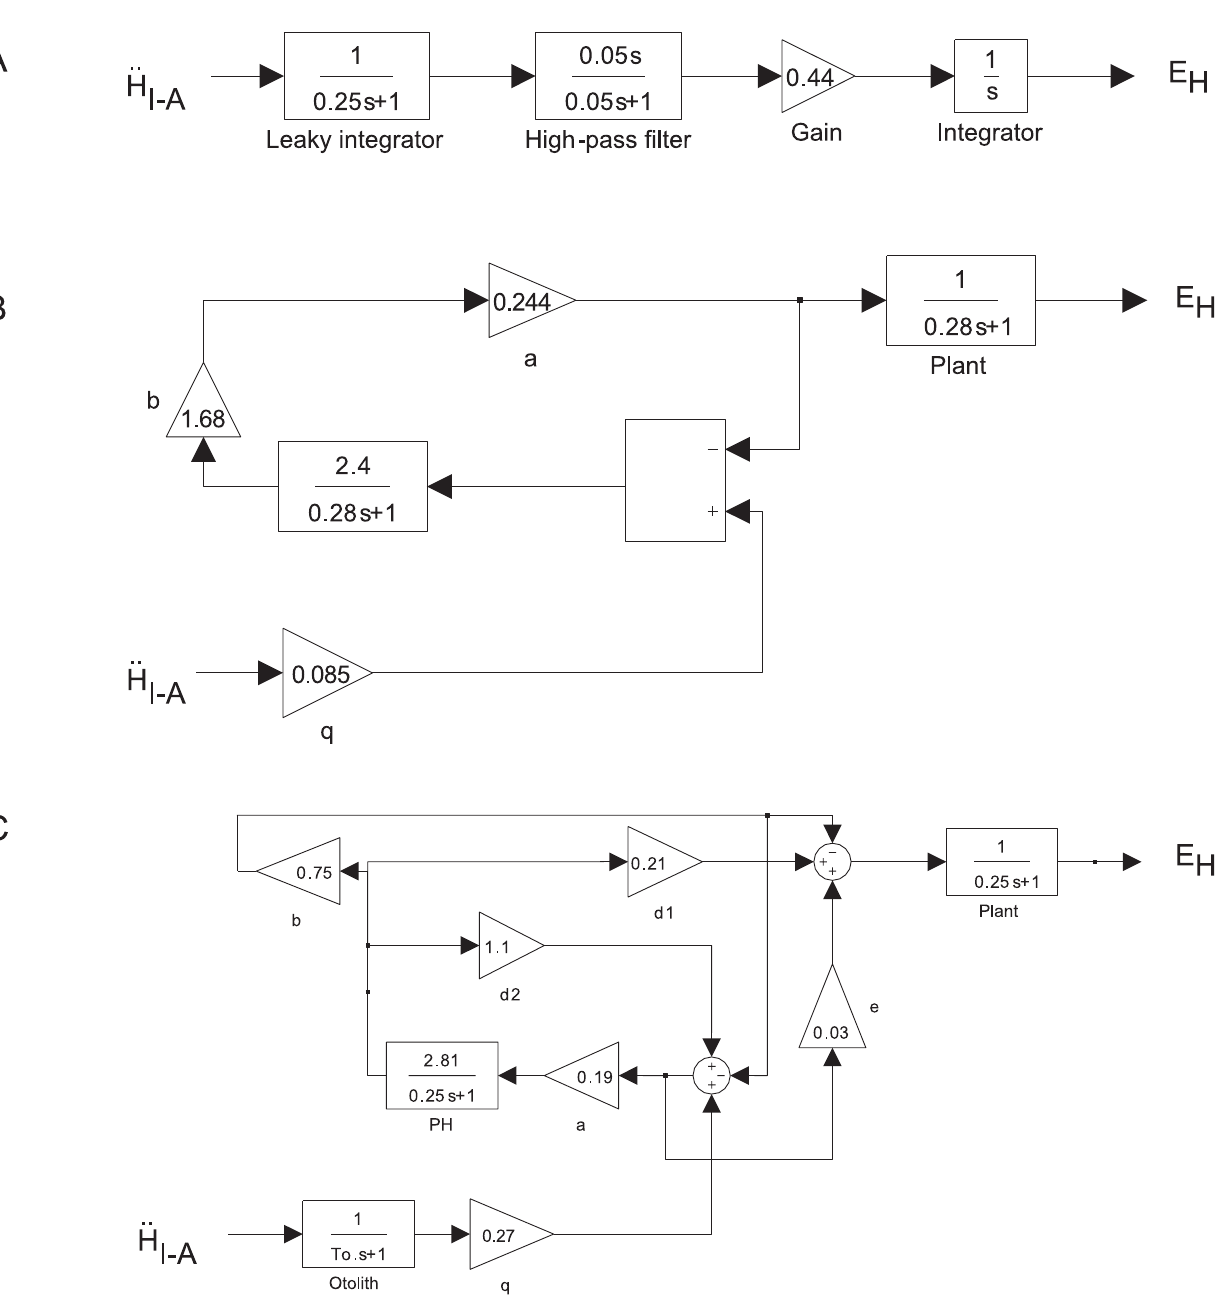
Figure 6. Schematics of Simulink representations of the three previous tVOR models whose behavior we compared to our own: a. Telford, et al. [ 40 ] , b. Green and Galiana [ 27 ] , c. Angelaki, et al. [ 25 ] . In each case, we used the parameters specified by the author (we did not fit the models to our data), but we scaled the output to match the peak simulated eye velocities and we matched the delay to that used in our model (31 ms). The input to each model was linear head acceleration from one of our steps of translation. As published, the Angelaki, et al., model (C) also included an input from the horizontal semicircular canal, which we omitted here, as we are considering only pure translational motion.